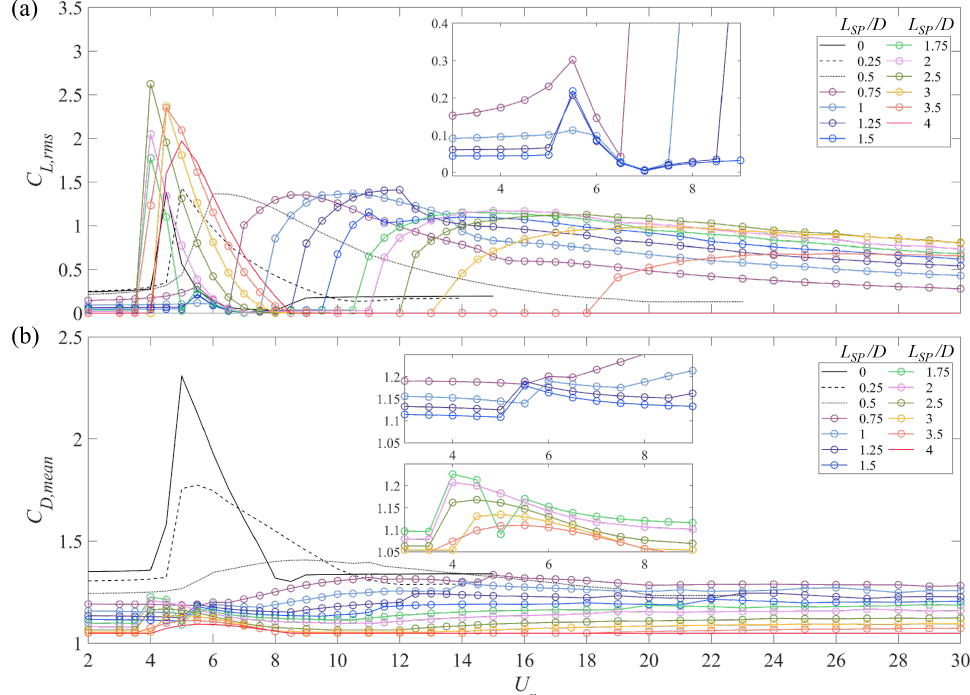
Figure 13. Variation of aerodynamic fluid forces acting on a cylinder-plate assembly: ( a ) the root- mean-square lift coefficient C L , rms and ( b ) the time-averaged (mean) drag coefficient C D , mean as a function of the reduced velocity U r and stratified with respect to the plate length L SP